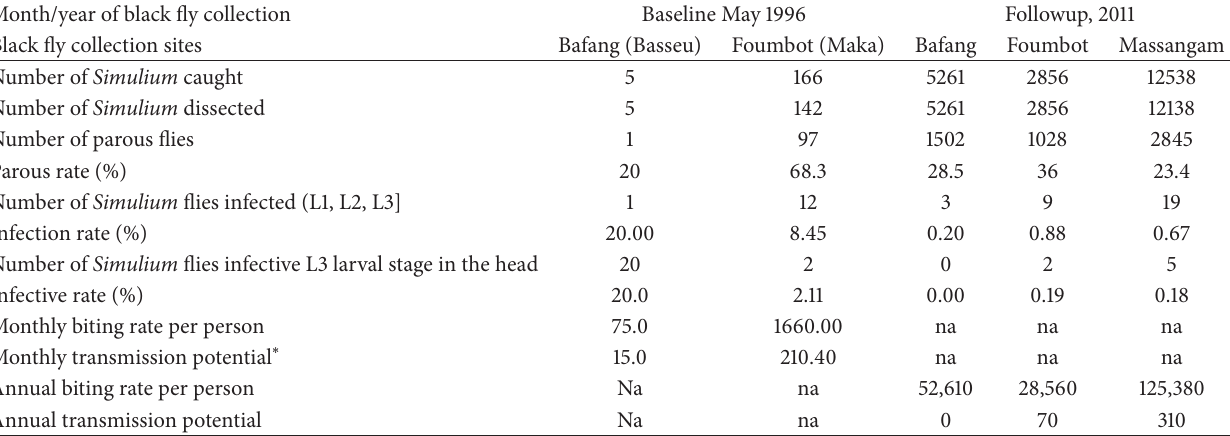
Table 5: Comparing baseline entomological data of 1996 at two fly collection sites and three during 2011.